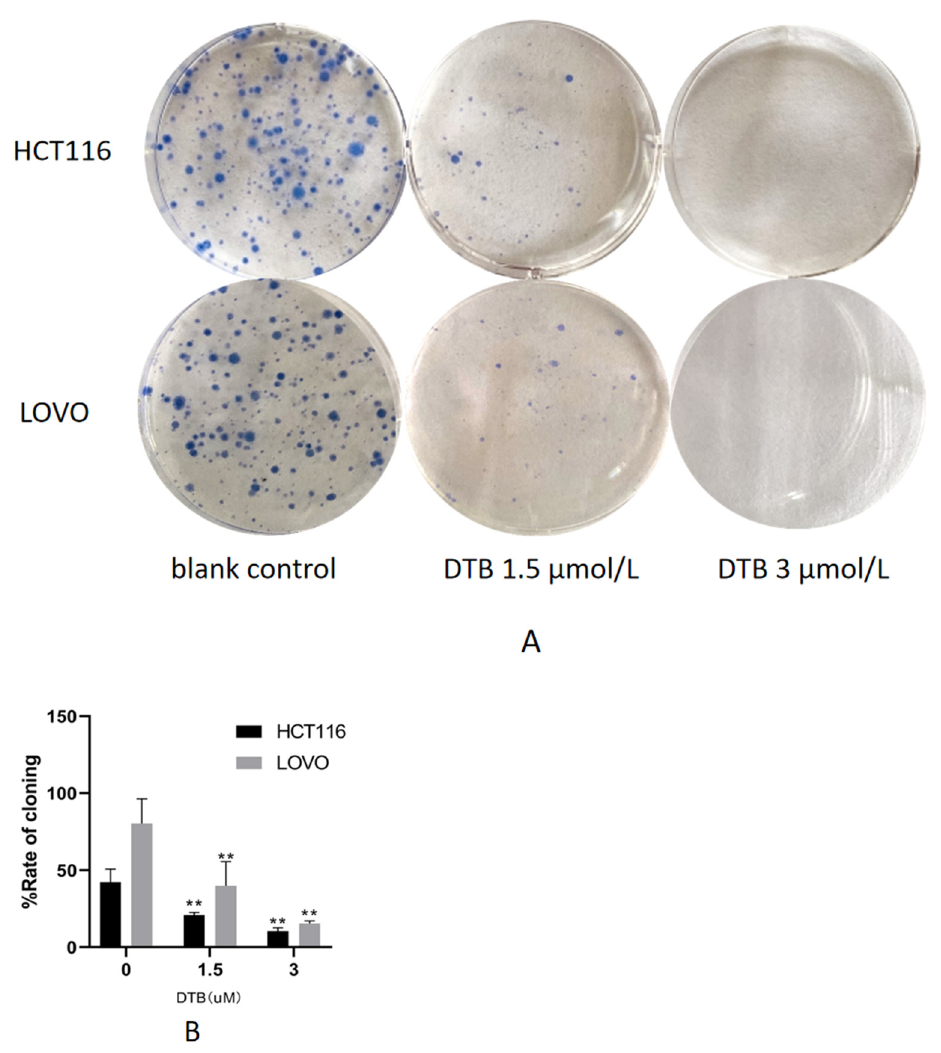
Figure 3. ( A ) The effect of DTB on colon cancer HCT116 and LOVO cells’ clone formation ability. The left is the blank control group, the middle is the DTB 1.5 μ mol/L group, and the right is the DTB 3 μ mol/L group. ( B ) Rate of clone formation. n = 3; each data point represents the mean ± standard error. Compared with the blank group, ** p < 0.01.